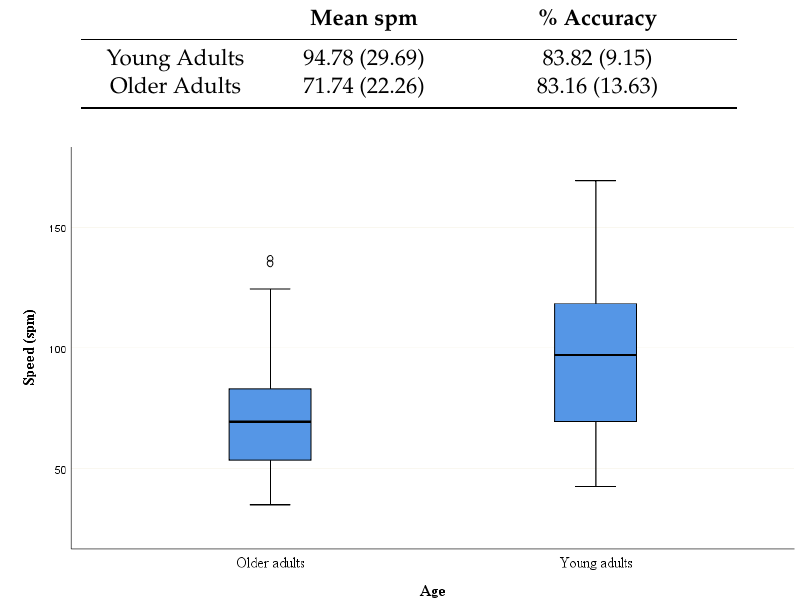
Figure 2. Speed (symbols per minute per column; spm) between young and older adults.